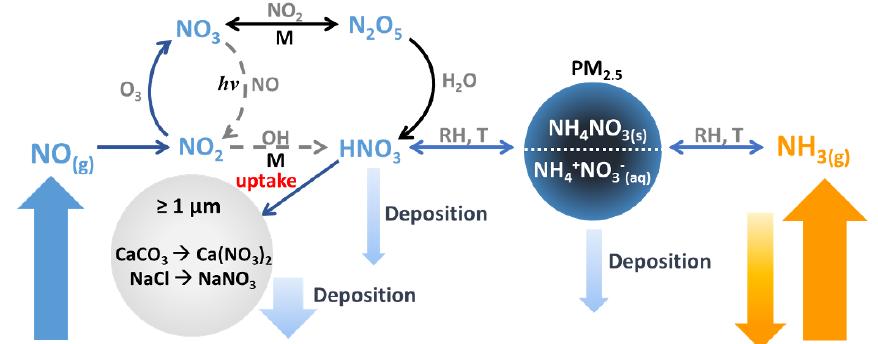
Figure 1. Processes influencing the concentrations of NH 3 , NO x , HNO 3 , and NH 4 NO 3 . Pathways that occur during the day are shown in dashed grey arrows, while pathways that occur during the night are shown in black. The rate of uptake of HNO 3 to coarse particles, ≥ PM 1 , composed of CaCO 3 and/or NaCl is